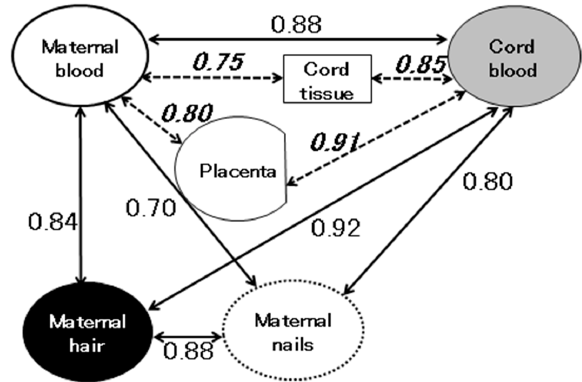
Figure 3. Correlation coefficients (r) for the relationships among biomarkers of methylmercury exposure at parturition. Note: Red blood cells were used to calculate the correlations between the levels of methylmercury in blood, the placenta, and cord tissue (---) [30]. Whale blood was used to calculate the correlations between the methylmercury levels of blood, hair, and nails ( ― ) [45].